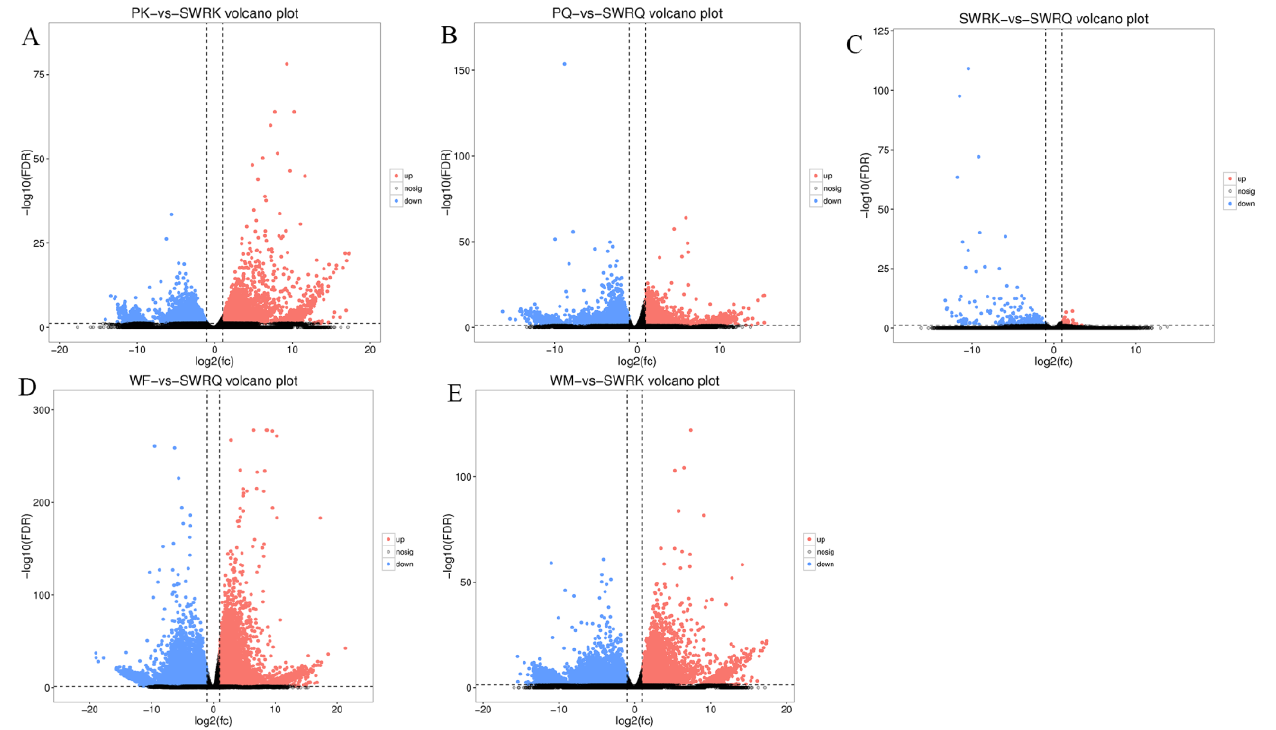
Figure 3. Differential expression of genes (DEGs) analysis across distinct castes of R. chinensis (SWRQ-vs-SWRK, PQ-vs-PK, and WM-vs-WF). The red column represents DEGs that are down- regulated, whereas the green column indicates DEGs that are up-regulated. To determine the significance of gene expression changes, FDR ≤ 0.001 and log2Ratio ≥ 1 were employed as thresholds.